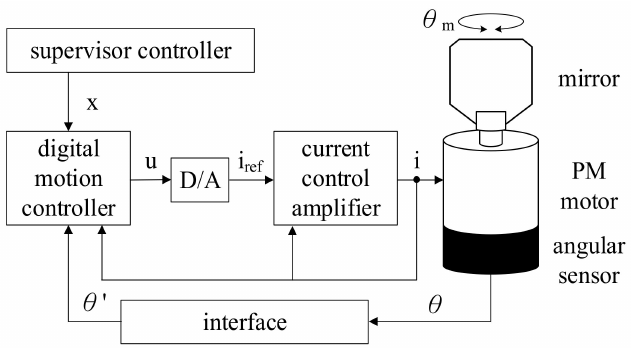
Figure 3. PM motor system.